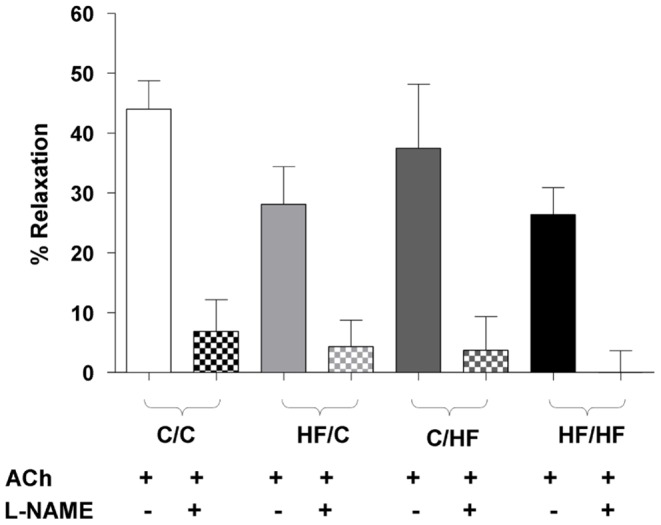
Impact of maternal HF-feeding on offspring NO-component of the ACh-induced vasorelaxation.Femoral dilation to ACh alone (open columns) or in the presence of L-NAME (100 µM) (shaded columns) in the four male offspring groups at 15 weeks of age. Within offspring group statistical comparisons were made using a paired t test. Data are mean ± SEM, (n = 4–6 per group). * p<0.01.